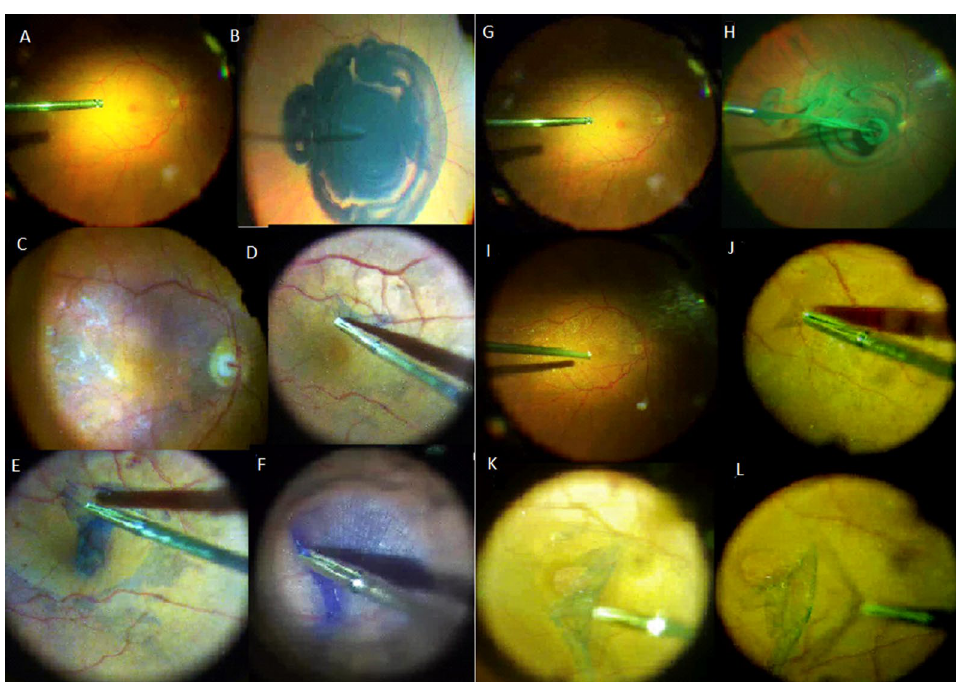
Figure 1. Pictures of internal limiting membrane (ILM) peeling phases using DoubledyneTM, macula before dye injection ( A ), dye injection ( B ), stained macula ( C ), ILM peeling ( D – F ) and using TWINTM, macula before dye injection ( G ), dye injection ( H ), stained macula ( I ), ILM peeling ( J – L